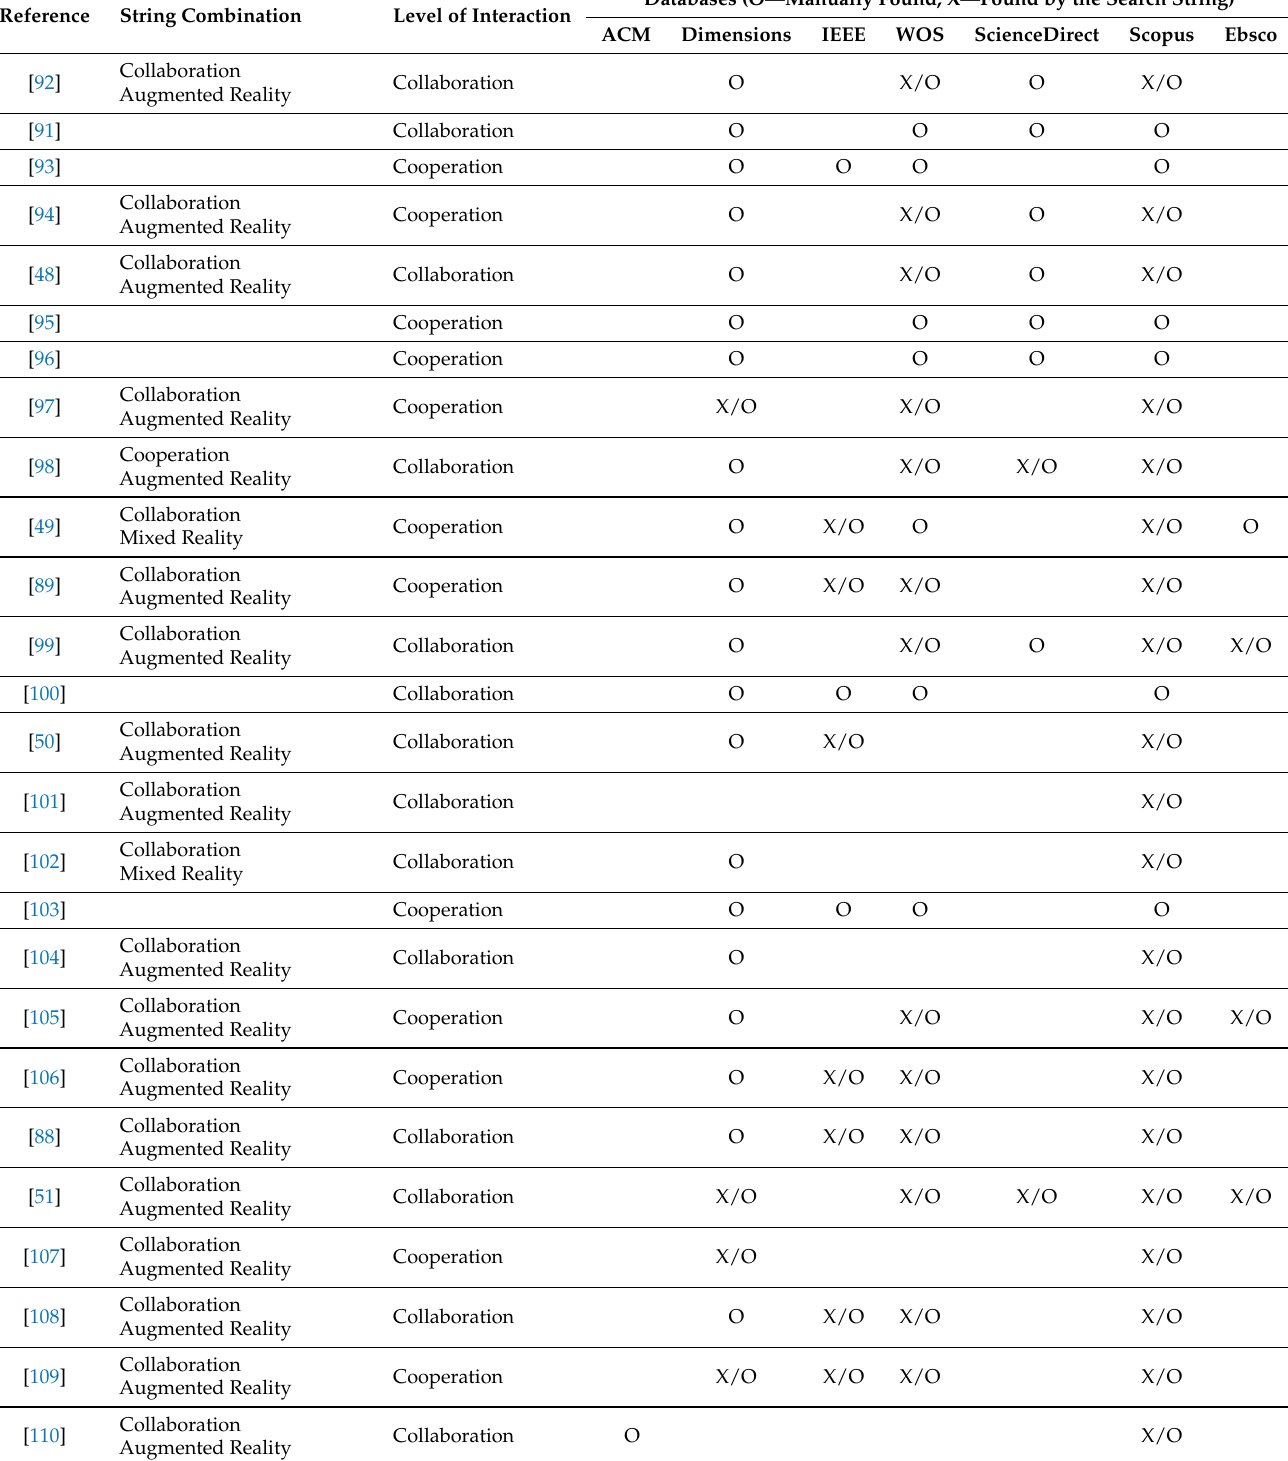
Table 9. Search general